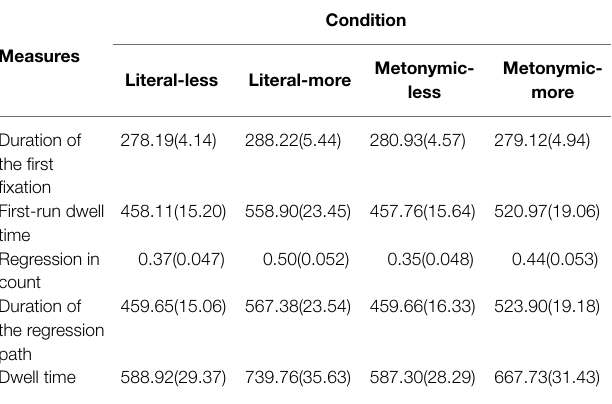
TABLE 2 | Mean reading time for the adverbial